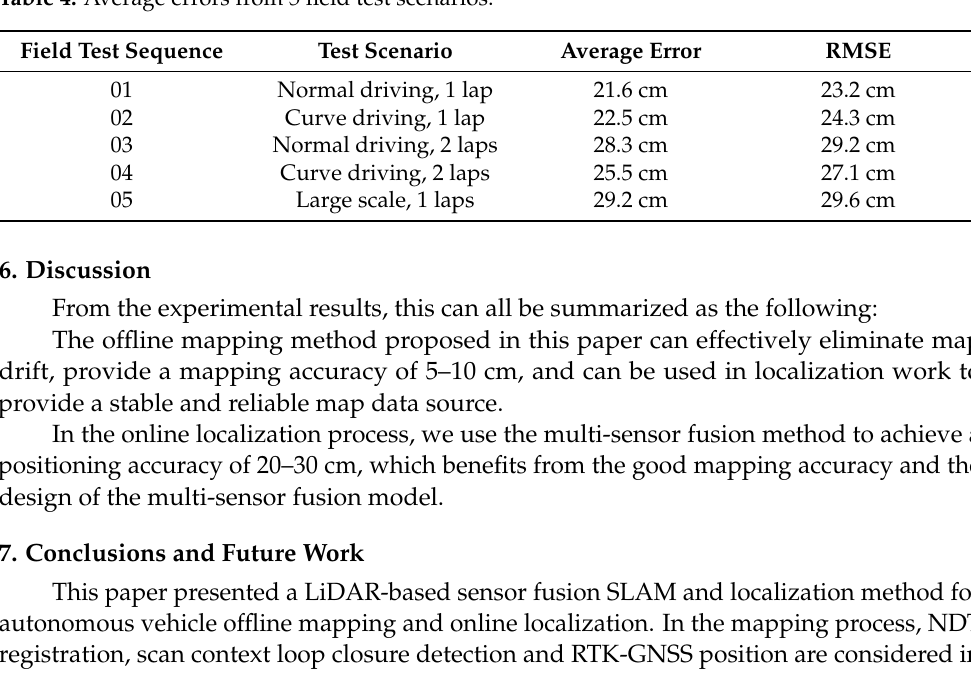
Figure 34. Field test NO.5. Large scale scenario localization error in longitudinal, lateral, and altitude directions, respectively; the localization error is at the centimeter level. Table 4. Average errors from 5 field test